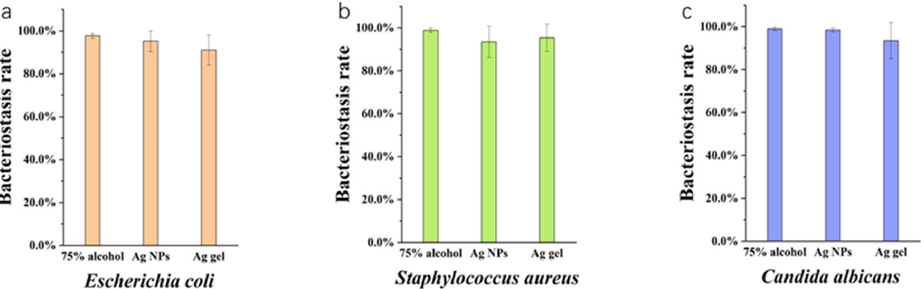
Figure 4. Antibacterial rate of 75% alcohol, Ag NPs (200 ppm) and Ag gel against ( a ) Escherichia coli (ATCC 25922), ( b ) Staphylococcus aureus (ATCC 25923) and ( c ) Candida albicans (ATCC 14053) (n = 3).